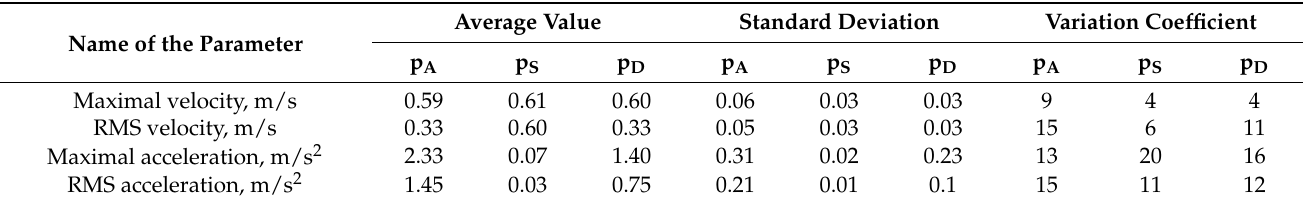
Table 2. Values of the calculated parameters for precise